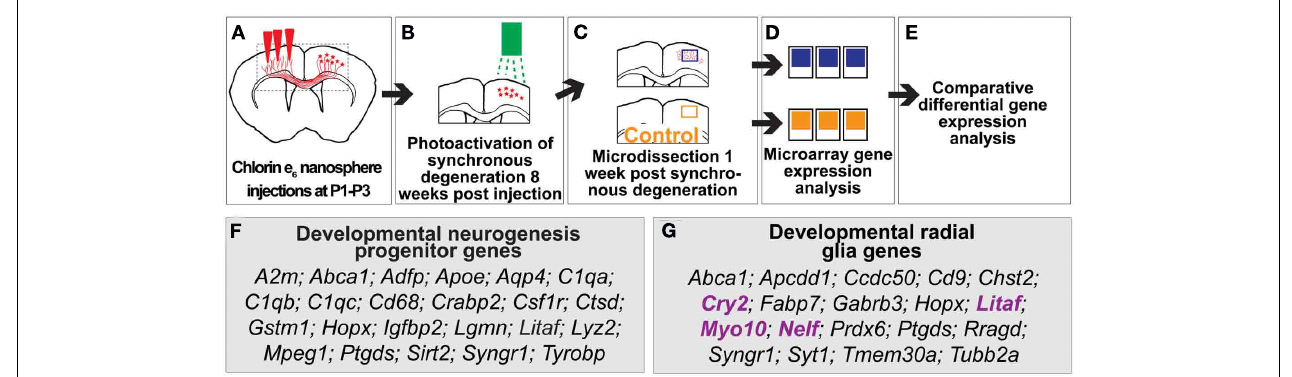
FIGURE 1 | Genes involved in developmental neocortical neurogenesis are differentially expressed in regions of induced young adult neocortical neurogenesis. (A–E) Approach to identify differentially expressed genes in regions of induced young adult neurogenesis. (A) Coronal representation of a mouse brain, indicating site of injection (red arrows) of chlorin e 6 -conjugated nanospheres into mice at postnatal day 1–3 (P1–P3; day of birth P0) to label callosal projection neurons (CPN; red somas in right cortex). Dashed box represents the area of focus in (B,C) . (B) Photoactivation of